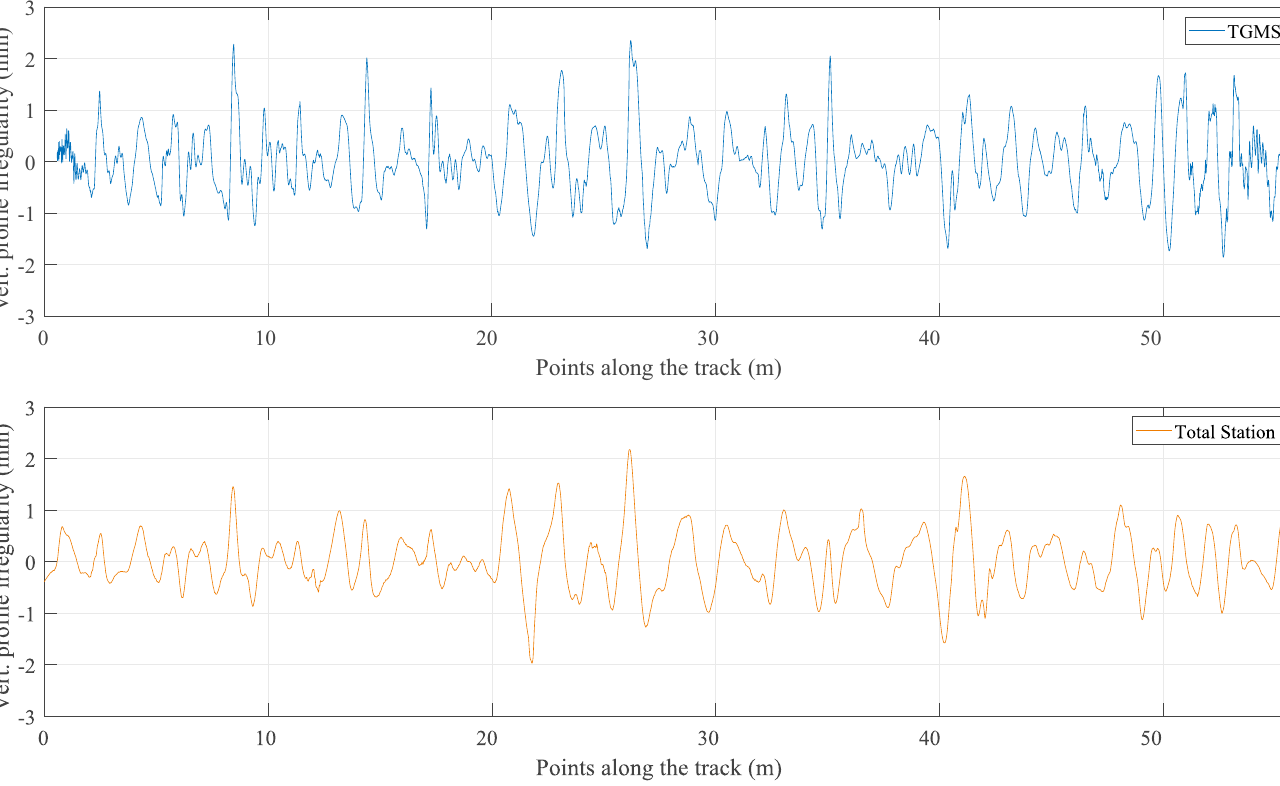
Figure 19. Measurements of vertical